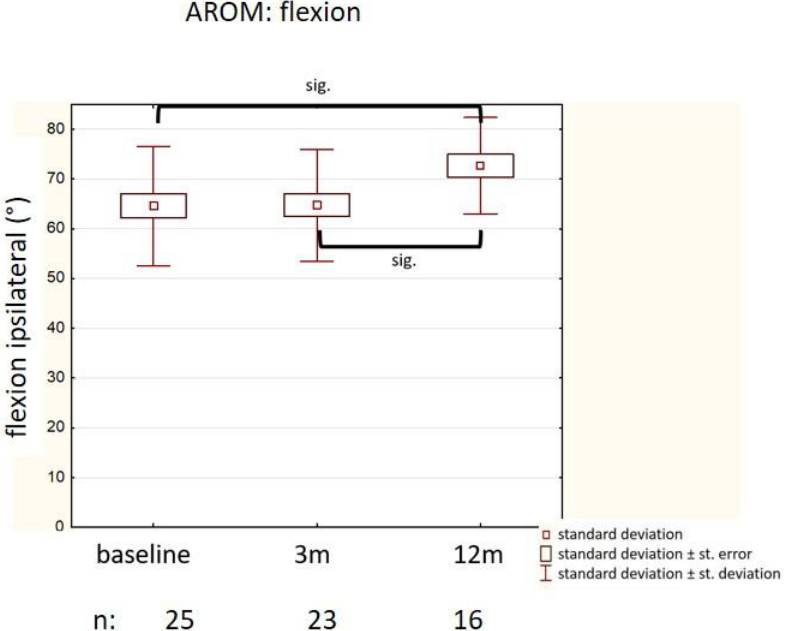
Figure 3. Improvement in flexion of the thumb (mean value, standard error, standard deviations are given at each time point).